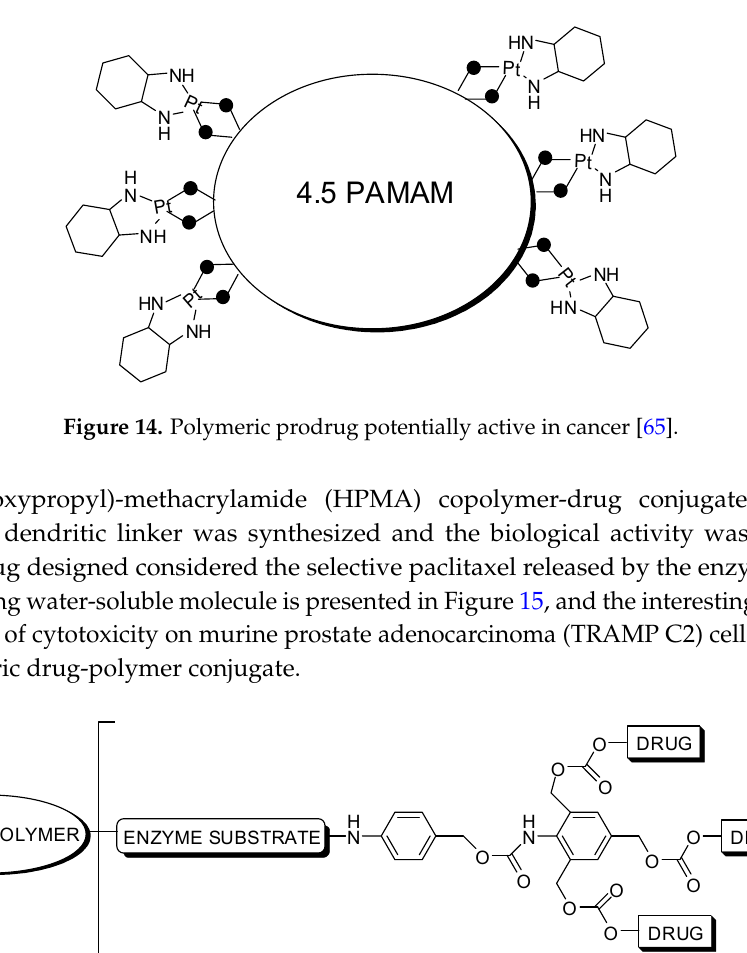
Figure 15. Polymer-drug conjugate designed to cancer therapy [66].